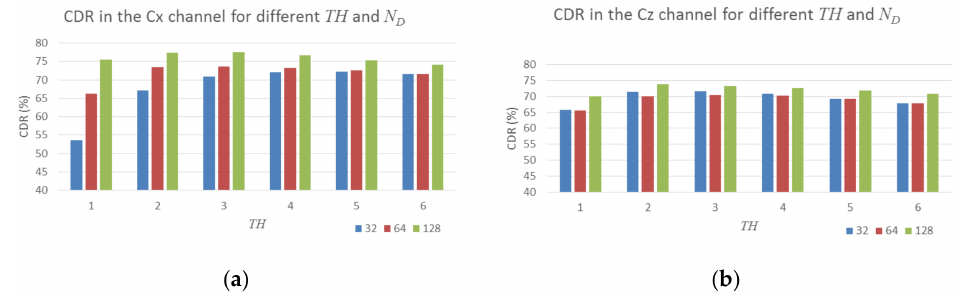
Figure 6. CDR for all images and capture devices using dictionary-based detector, in the Cx ( a ) and Cz channel ( b ), depending on the dictionary size N D (color-coded) and the number of atoms used in the detection TH